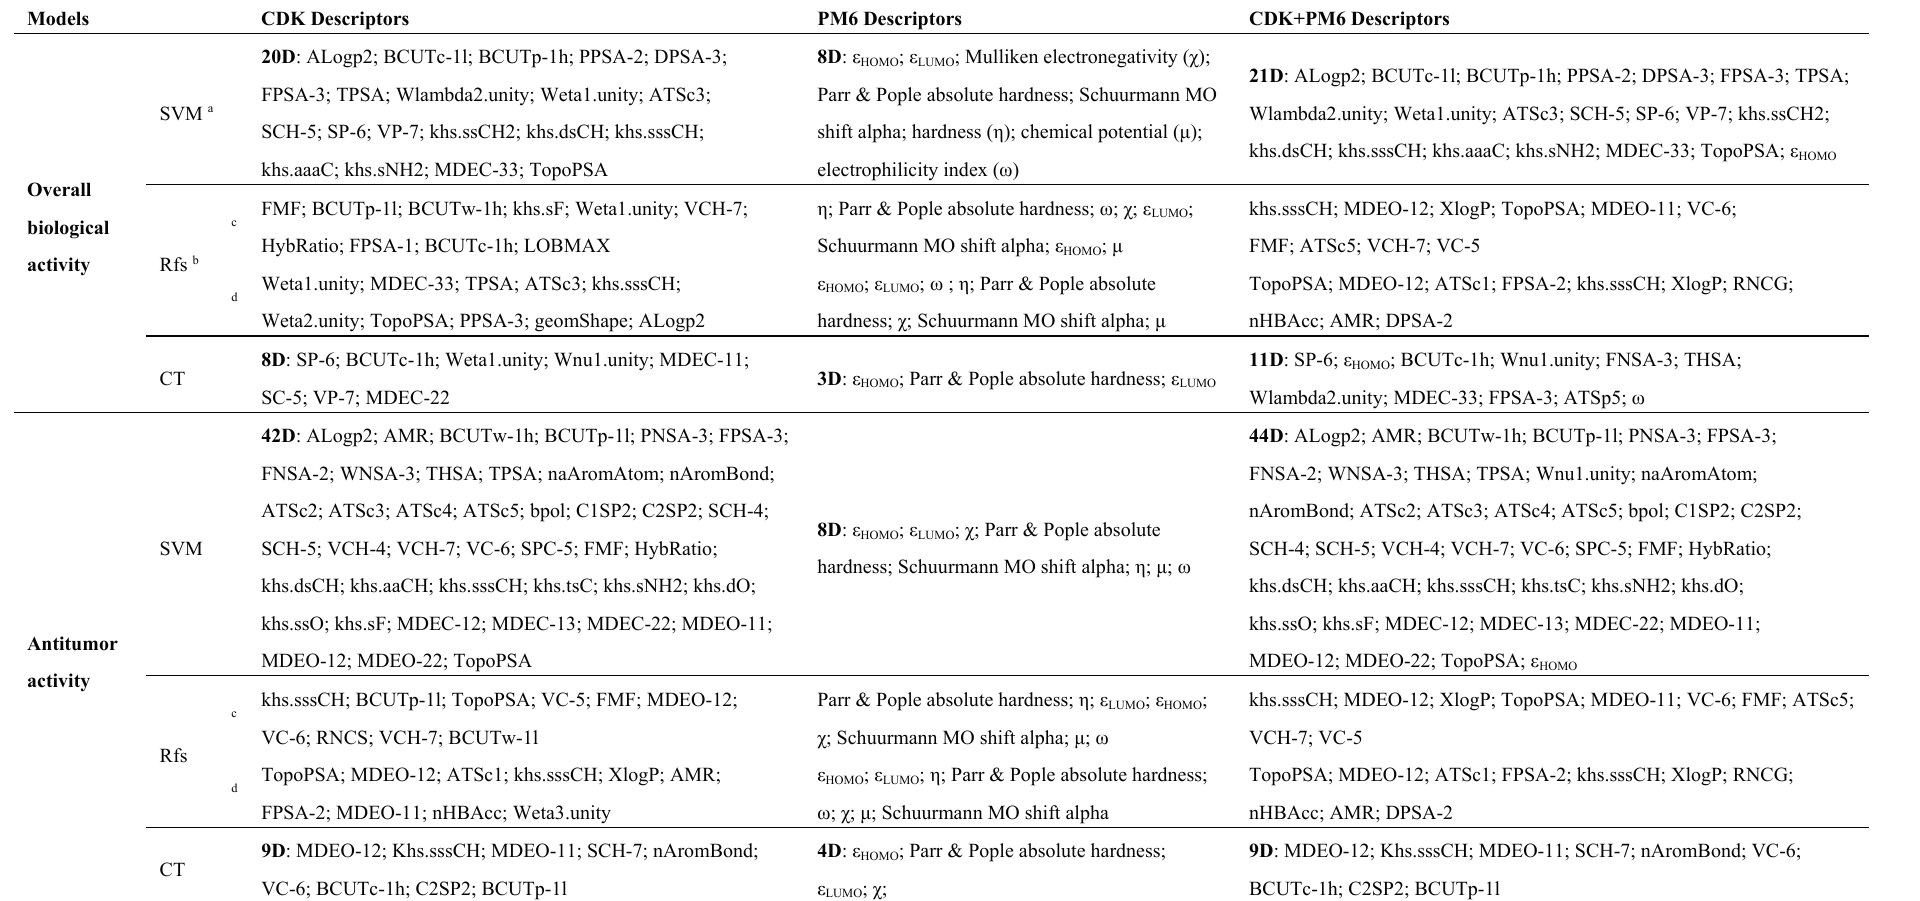
Table 5. Comparison of descriptors selected with descriptor importance using to build QSAR